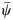
(a) Schematic of an infinitely long, periodic tube of longitudinally asymmetric profile exhibiting particles introduced (ψ¯) in the central wave-section and migrating out under diffusion and convection. (b) Detailed schematic of an axi-symmetric, smoothed, saw-tooth tube. Non-dimensional geometric construction particulars are indicated in the figure. The leading edge of the saw-tooth profile is that part in the positive z half of the wave-section having the steeper sloped boundary. The trailing edge is the shallower sloped boundary.